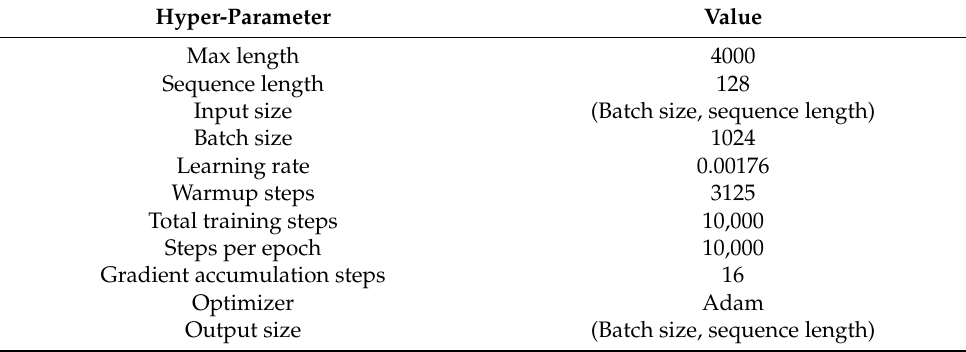
Table 3. Parameters during MPE